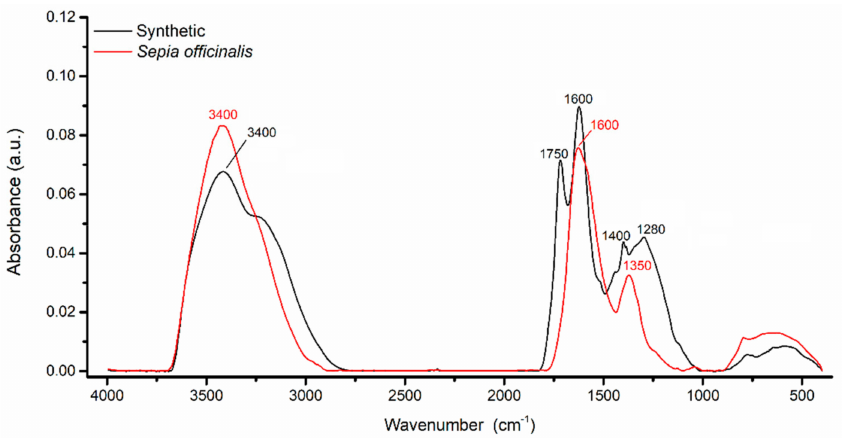
Figure 7. The FTIR spectra of Sepia o ffi cinalis (red) and synthetic (black)